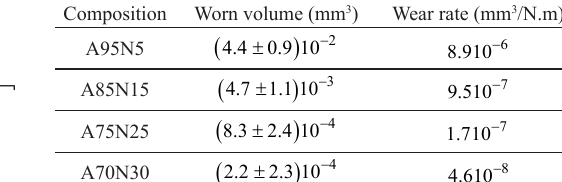
Table 4. Wear volume and wear rate for the 2 3 Al O -NbC composites